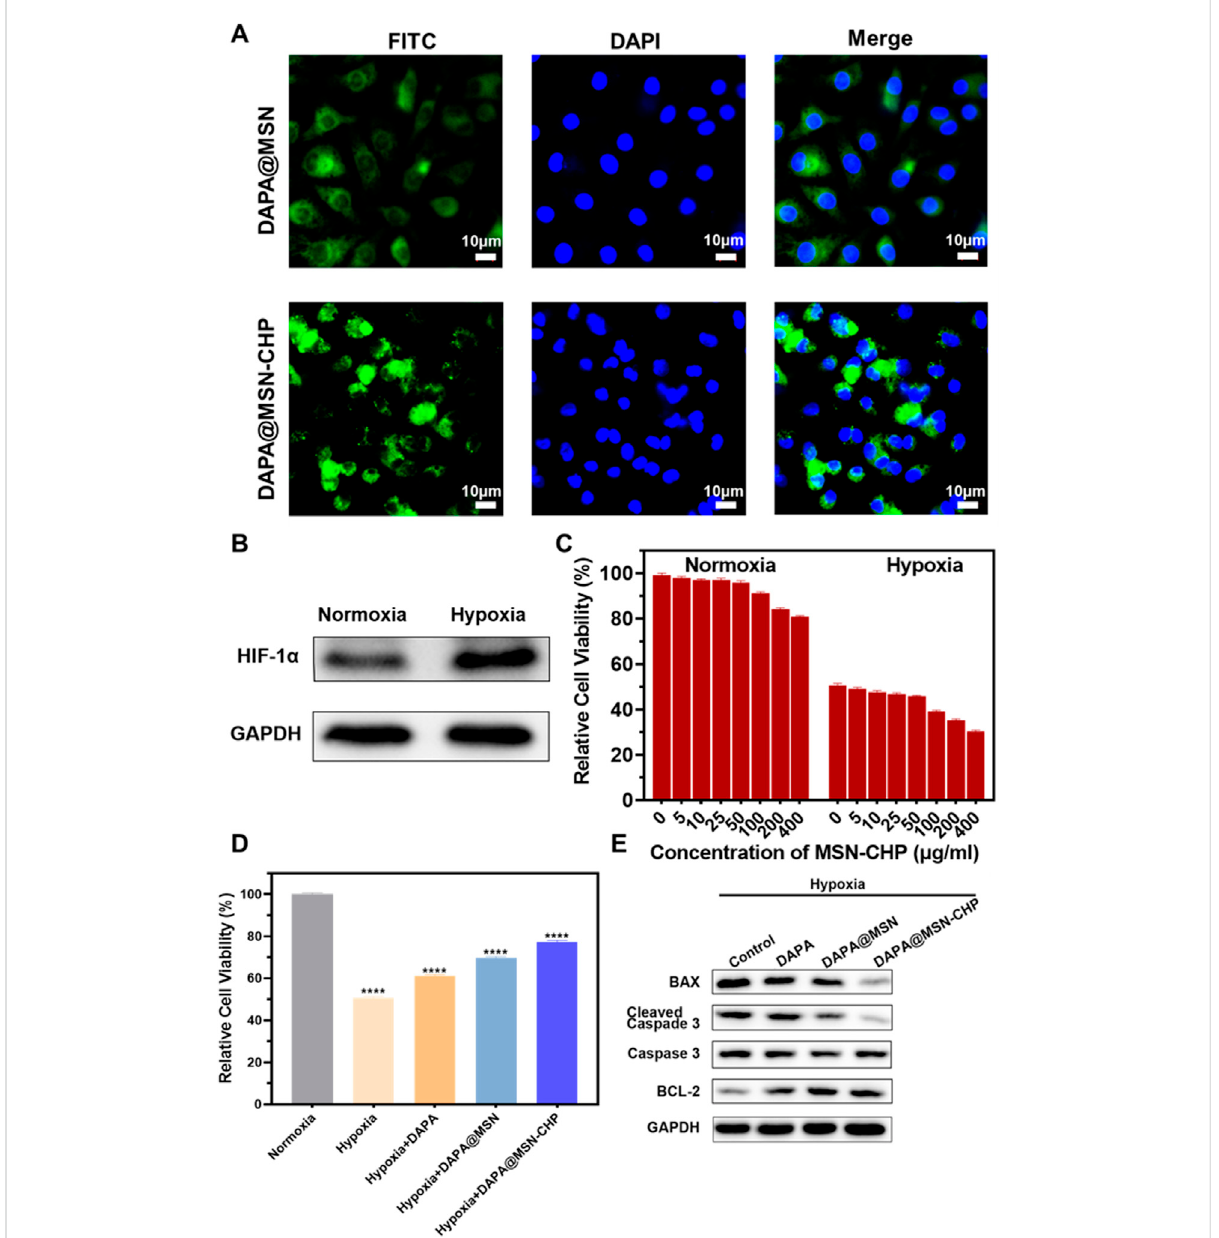
FIGURE 3 CLSM images of DAPA@MSN-CHP and DAPA@MSN with 12 h incubation (A) . Western blot result of HIF-1 α expression in HF tissues and normal tissue (B) . Cell viabilities of cardiomyocytes toward MSN-CHP under hypoxia and normoxia conditions (C) . Cell viabilities of cardiomyocytes after differenttreatmentsinhypoxicconditions. Purenormoxiaconditionwassetasthecontrolgroup (D) .Bax,cleavedCaspase-3,Caspase-3 andBCL-2 expressions of cardiomyocytes after different treatments under hypoxia conditions (E) . All error bars represent mean ± SD ( n = 4). Data